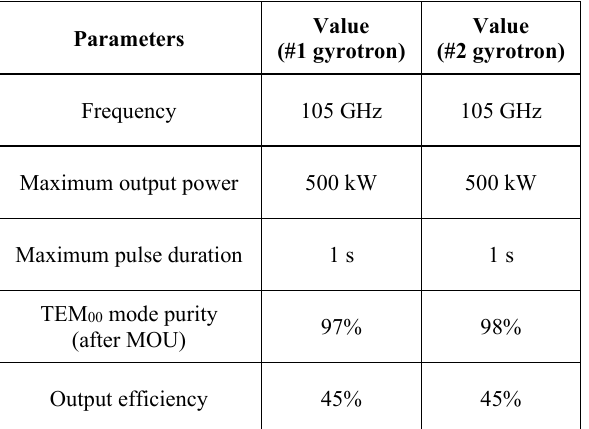
Table 2. Main characteristic parameters of the gyrotrons for J-TEXT ECRH system.